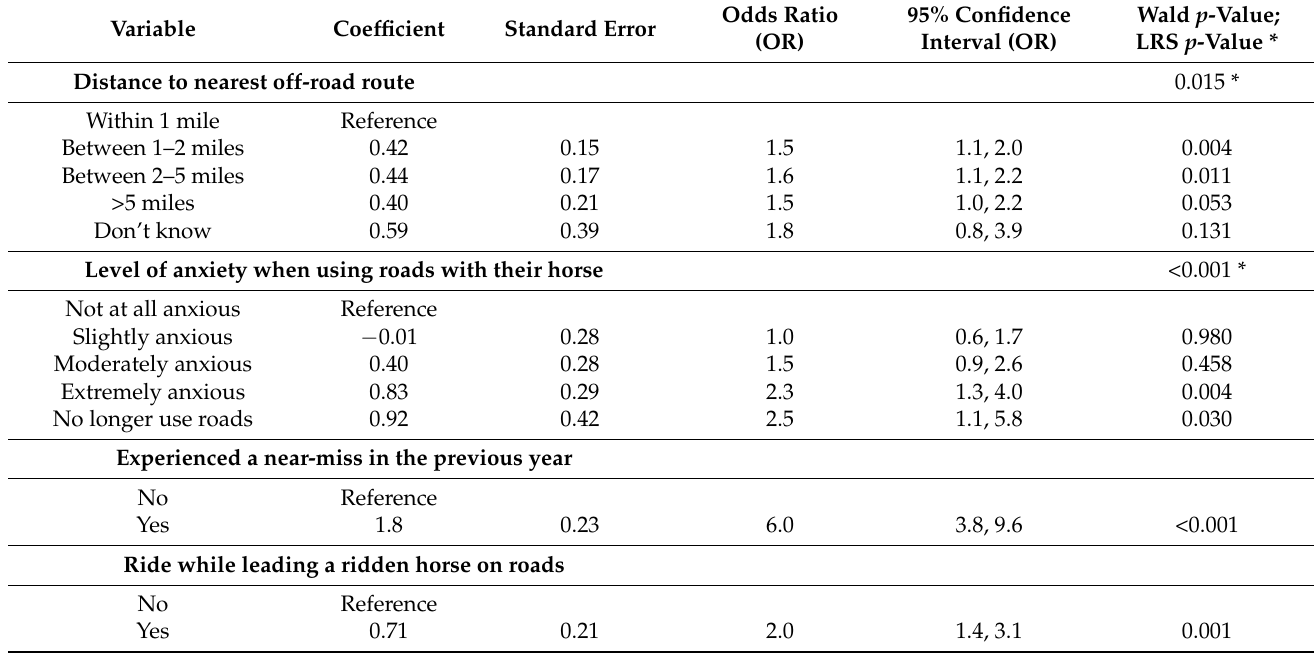
Table 6. Multivariable logistic regression modelling to identify factors associated with higher odds of having had a road- related injury-causing incident (injury to equestrian and/or horse) while using roads with a horse in the previous year (based on responses from 5122 UK equestrians in October